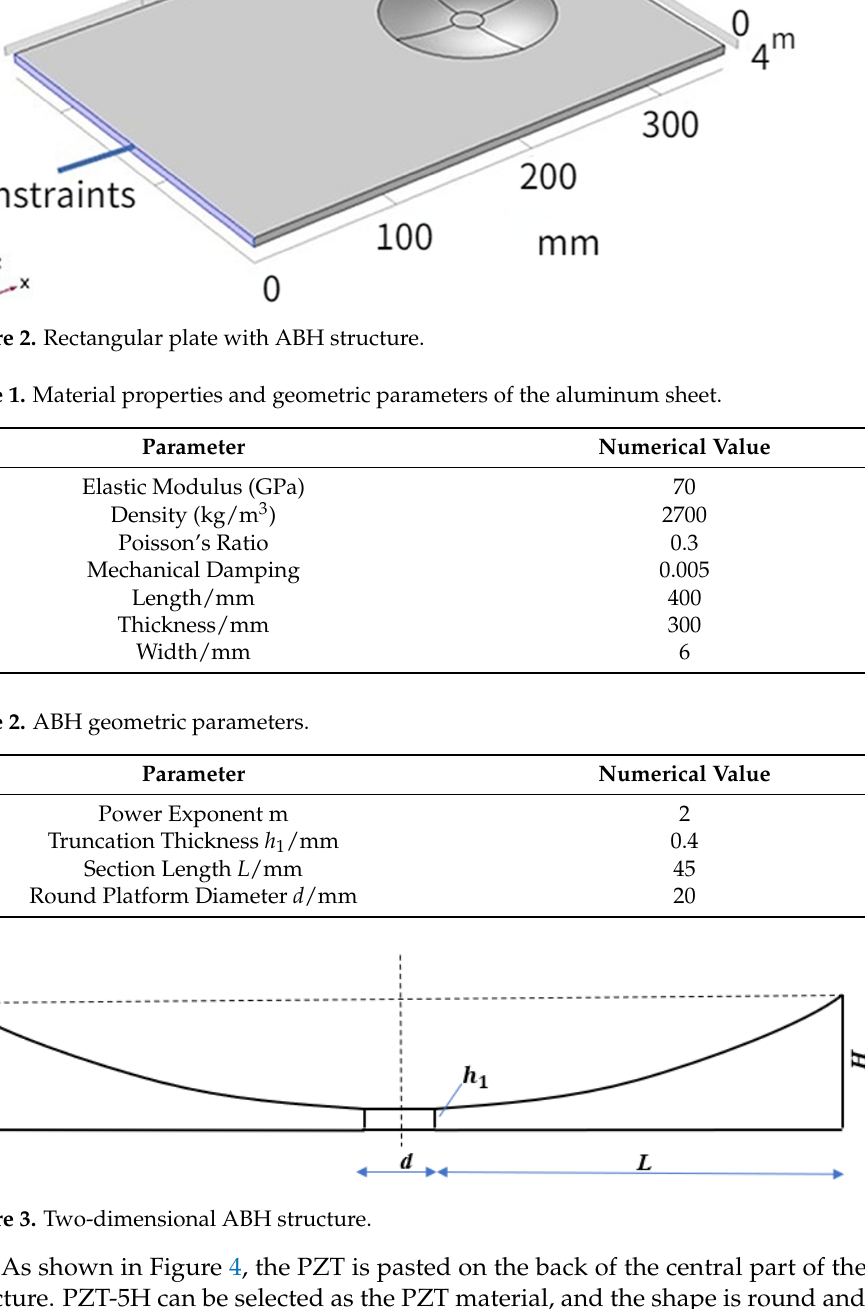
Figure 3. Two-dimensional ABH structure.